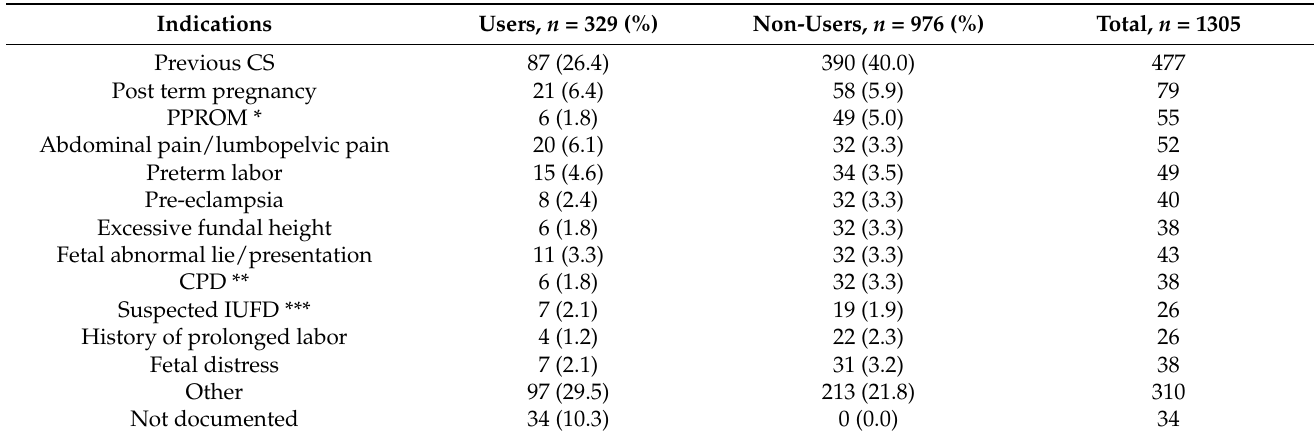
Table 1. Indications for admission to the MWH.